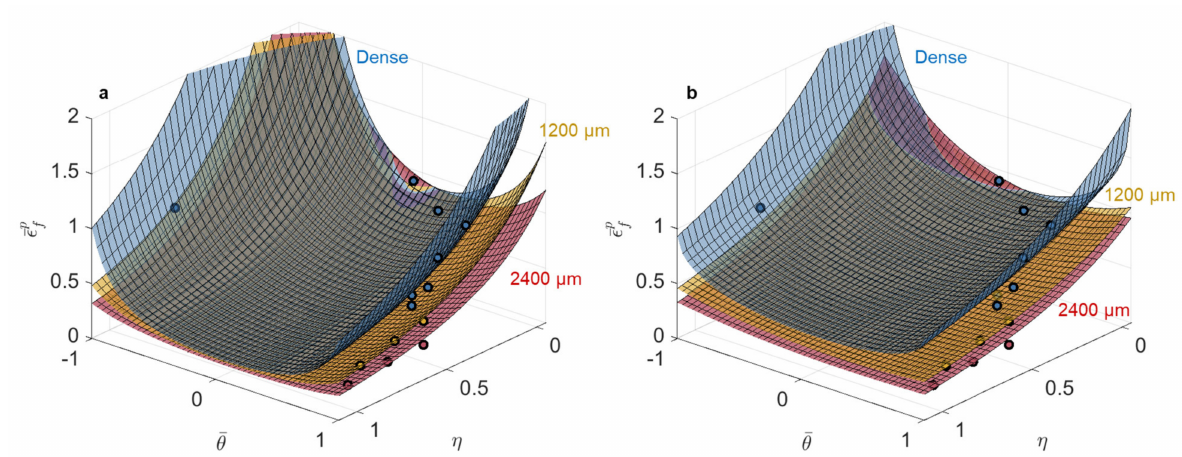
Figure 4. Calibrated ( a ) modified Mohr–Coulomb and ( b ) Hosford–Coulomb fracture loci in stress triaxiality vs. Lode angle parameter vs. equivalent plastic strain space for 316L using the dense, 1200 µ m, and 2400 µ m pore data. Note that the horizontal positions of each symbol correspond to the average stress triaxiality and Lode angle parameter during loading, while the vertical position corresponds to the experimental strain to failure of the average stress state under the assumption of proportional loading; therefore, the symbols are not expected to lie on the fracture surfaces, which took into account loading history in the accumulation of